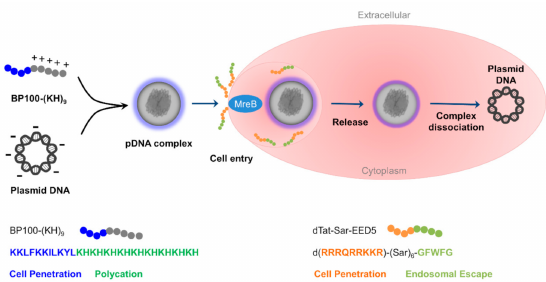
Figure 6. Schematic representation of the dual peptide delivery system of plasmid